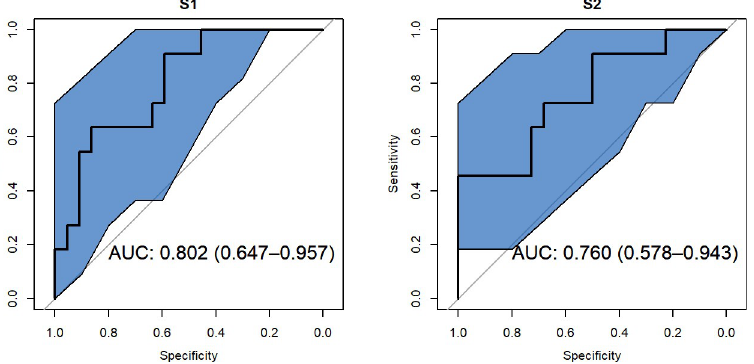
Fig 3. ROC Curves for Joint Model (Model 2) to Predict Death Using IgG Titer Values. Area under the curve (AUC) is presented within figure with 95% confidence intervals (shown in the blue regions) for specific IgG antibodies to S1 and S2,